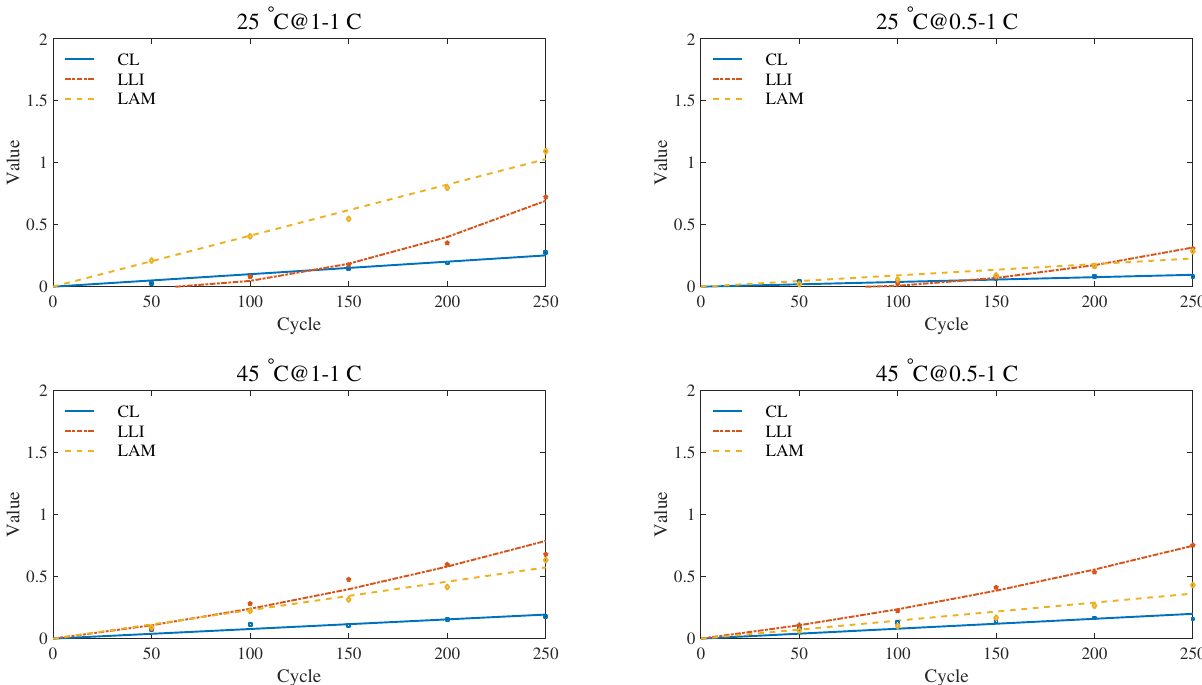
Figure 11. Quantitative results of degradation modes of lithium-ion batteries under different conditions, using 500 mA current excitation and 50% SoC for EIS